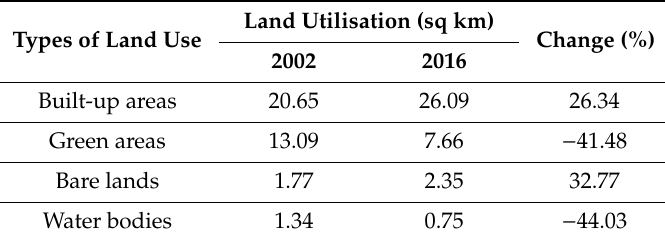
Table 3. Changes in Land Utilisation in Nakhon Ratchasima City between 2002 and